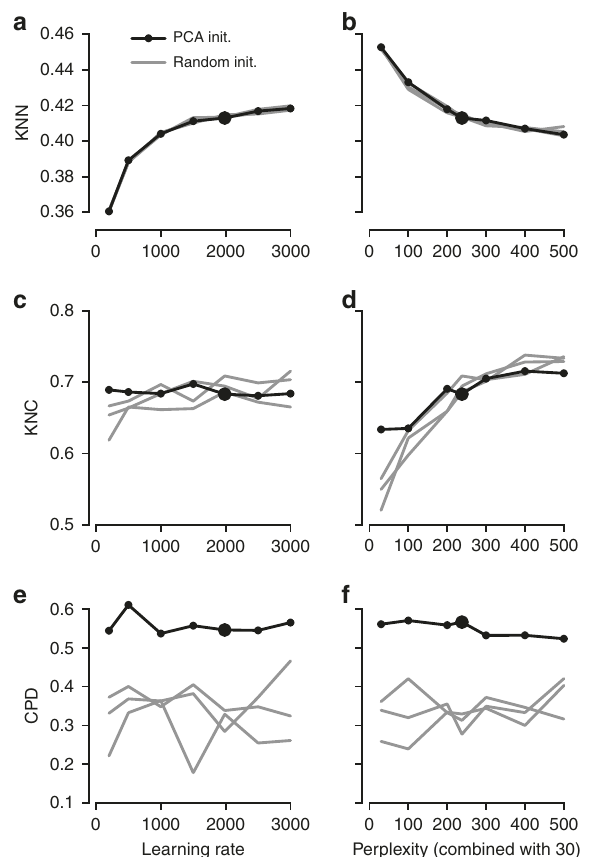
Fig. 3 The in fl uence of parameter values on embedding quality. All panels show quality assessments of various t-SNE embeddings of the Tasic et al. data set. a 10-nearest neighbours preservation (KNN) as a function of learning rate. Black line shows PCA initialisation, grey lines show random initialisations with three different random seeds. Large black dot denotes our preferred parameter values. Perplexity combination of 30 and n = 100. b 10-nearest neighbours preservation as a function of perplexity used in combination with perplexity 30. Learning rate n = 12. c – d The same for 10- nearest classes preservation (KNC). e – f The same for Spearman correlation between pairwise distances